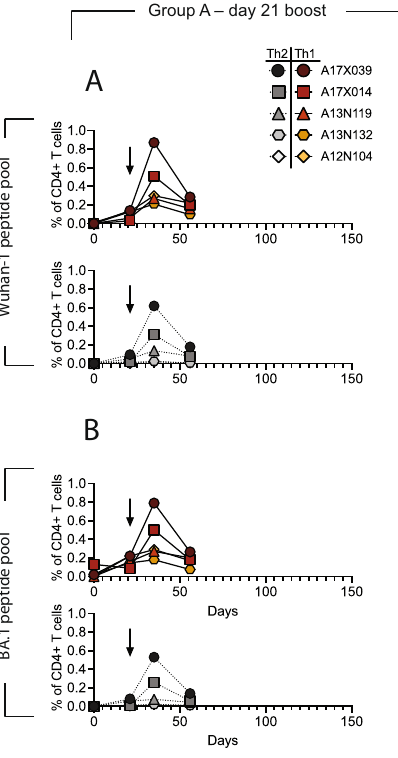
Fig.6|DCFHP-alumimmunizedNHPsshowsabalanceddistributionofTh1and Th2 CD4+T cell responses. T cells from animals in group A, isolated on the day shownonthex-axis,werestimulatedwithapeptidepoolderivedfromWuhan-1( A ) or Omicron BA.1 ( B ) spike protein and Th1 (top) and Th2 (bottom) cytokines were measured using fl ow cytometry (SI Fig. 9). Percent of CD4+T cells that express either Th1 (IL-2, IFNg, or TNFa) (yellows and reds) or Th2 (IL-4) (grays) cytokines